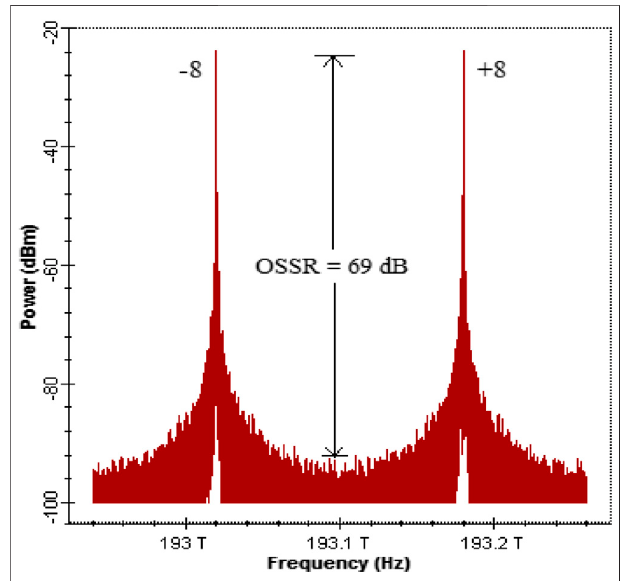
FIGURE 3 | Optical spectrum analyzer output from MZM-D.